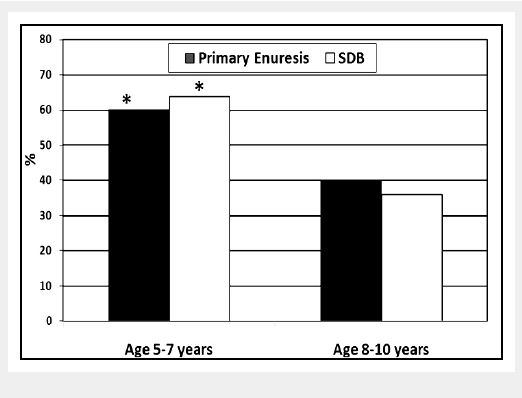
The incidence of primary nocturnal enuresis and SDB in relation to age. ( *indicates p <0.05).